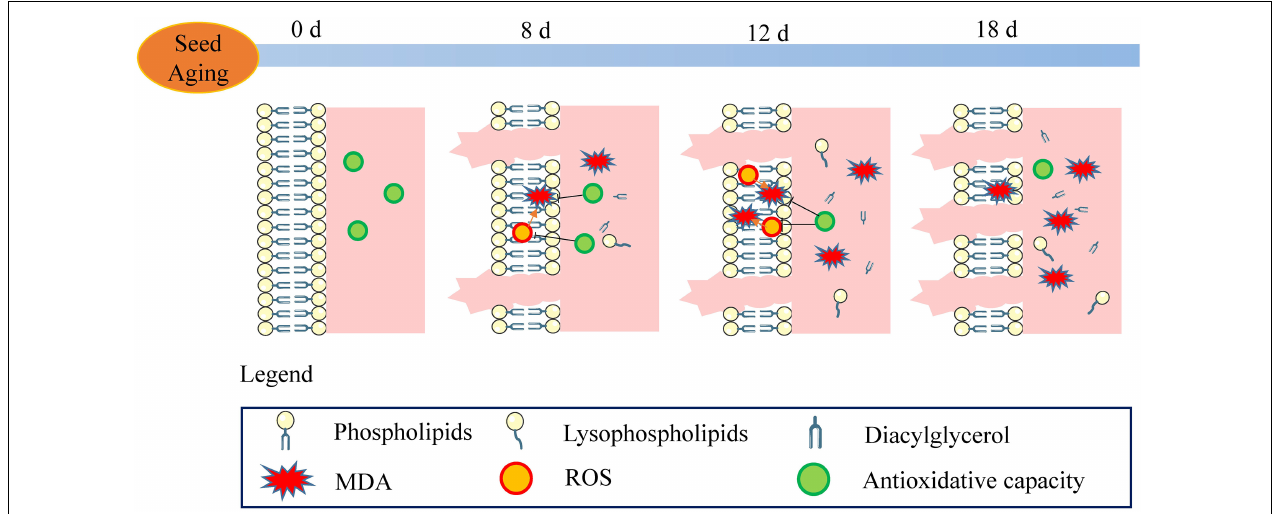
FIGURE 10 | Schematic of the metabolic events occurring during seed aging. The stable membrane structure and high antioxidant capacity were observed in the unaged seeds (aged for 0 d). With the increase in ROS content and the decrease in antioxidant capacity, lipid peroxidation (MDA) and electrolyte leakage were enhanced. The phospholipid degradation and the increase in lysophospholipid and diacylglycerol were observed in the 8 d-aged seeds. ROS steadily increased along with seed aging (12 d) leading to a decrease in the antioxidant capacity and an increase in the MDA content. Compared to the reduction in the phospholipid content, the content of lysophospholipid and diacylglycerol increased gradually. In the 18 d-aged seeds, ROS content decreased and electrolyte leakage increased. In the course of seed aging, these events result in the loss of seed viability.